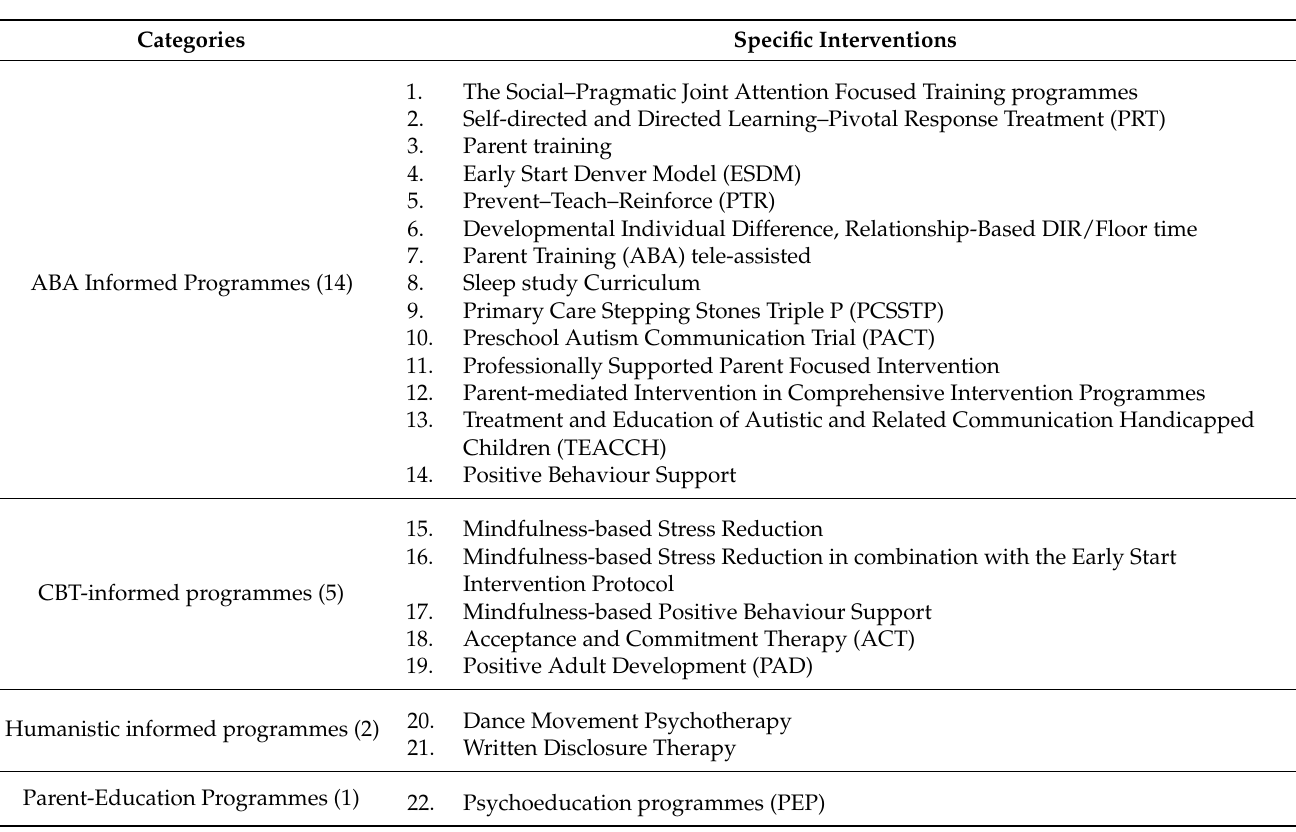
Table 1. Categorisation of specific interventions into four major